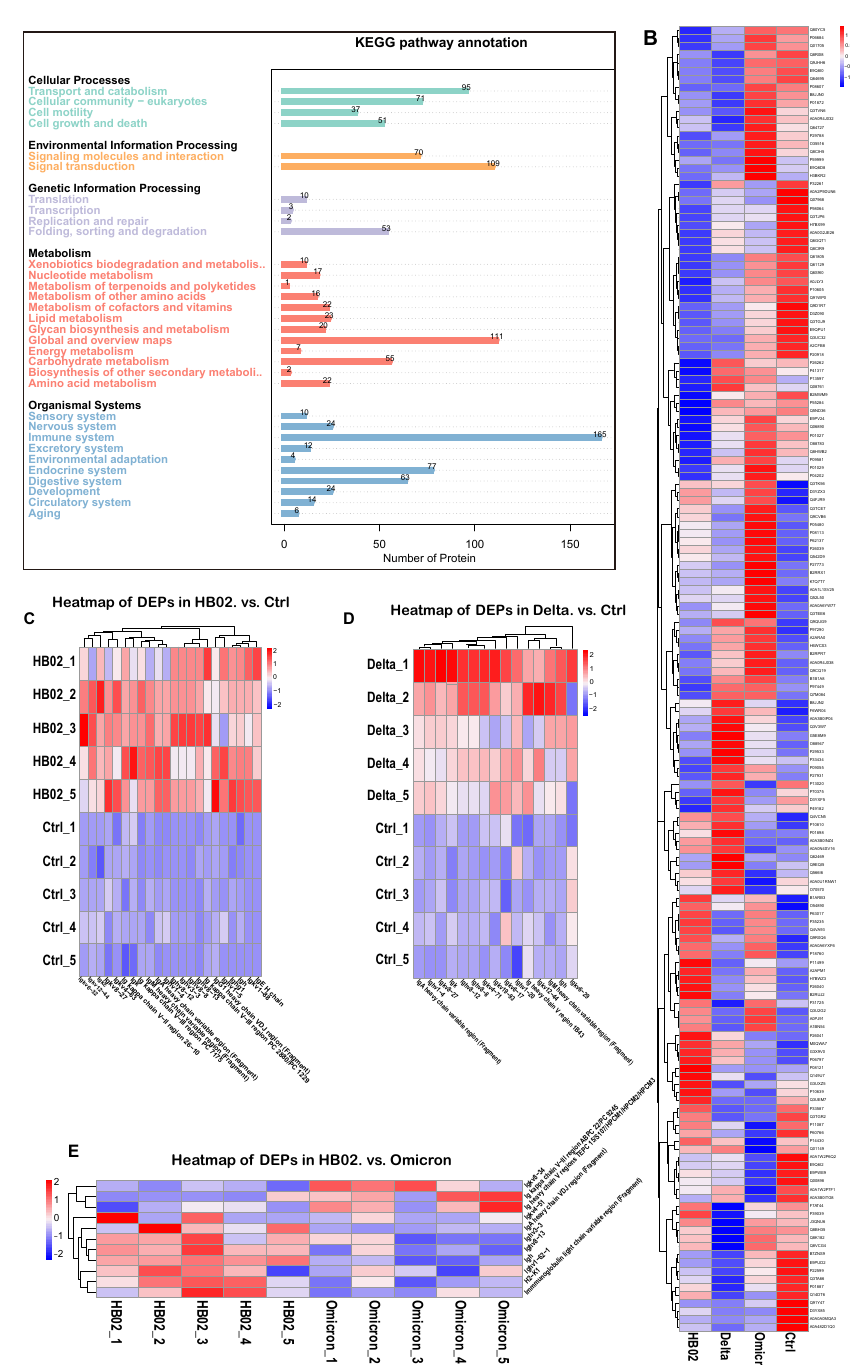
Figure 4. The change in the proteins induced by vaccines. ( A ) Biochemical metabolic pathway and signal transduction pathway analysis of proteins obtained by proteome sequencing using KEGG. ( B ) Heatmap analysis of DEPs from different groups. ( C ) Heatmap analysis of selected DEPs from HB02 vs. ctrl. ( D ) Heatmap analysis of selected DEPs from Delta vs ctrl. ( E ) Heatmap analysis of selected DEPs from HB02 vs.